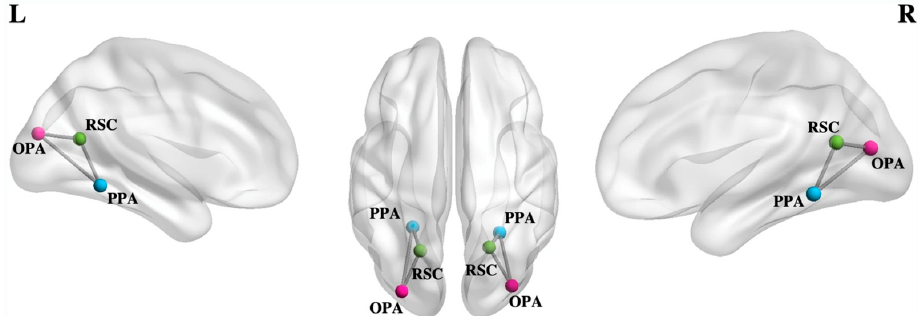
Figure 4. Anatomical location of regions of interest. Nodes of each region are displayed in different colors: the parahippocampal place area (PPA) is represented in sky-blue; retro-splenial complex (RSC) is represented in green; and occipital place area (OPA) is shown in pink. The edges between regions represent the connections separately modelled for each hemisphere in the Dynamic Causal Modelling (DCM) analysis. Reprinted with permission from ref. [52]. 2022. M G Tullo. Regions of each hemisphere were visualized using the BrainNet Viewer [53].